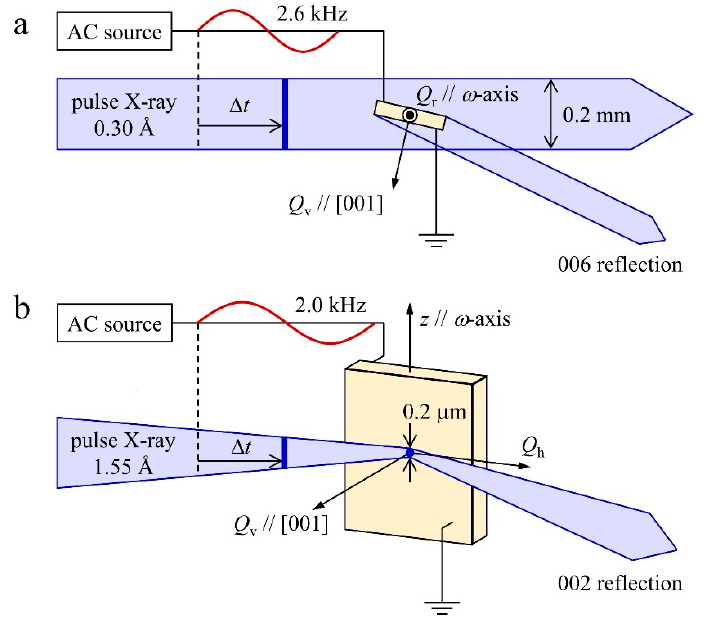
Figure 1. Schematic layouts of ( a ) time-resolved XRD for average structure under AC field and ( b ) time-resolved nanobeam XRD for local structure under AC field.